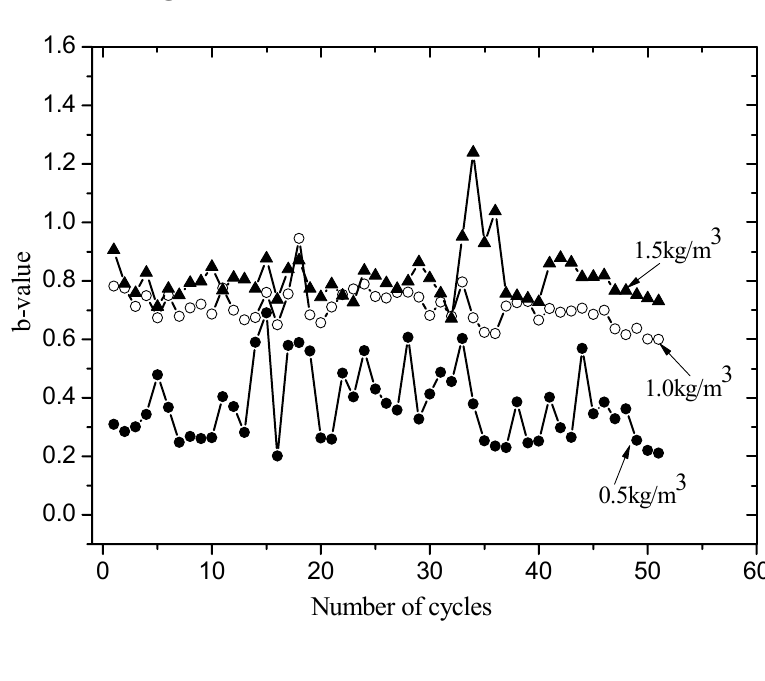
Figure 11. b -value for PVA fiber